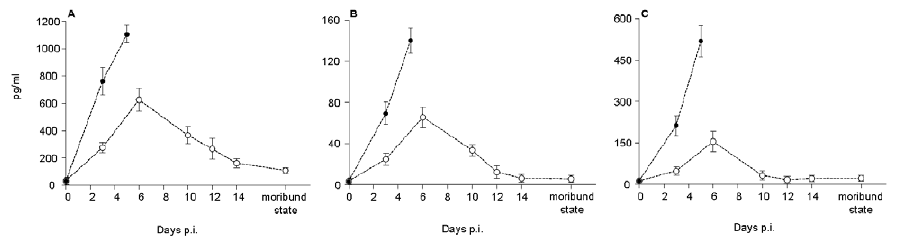
Figure 7. Pro-inflammatory cytokine expression in D2Y98P-infected mice. AG129 mice were ip. infected with 10 7 or 10 4 PFU of D2Y98P, bled at the indicated time points and immediately euthanized. Serum levels of IFN- c (A), IL-6 (B) and TNF- a (C) were quantified. Results are expressed in pg/ml as the [mean 6 SD] of 5 mice per time point and per group.